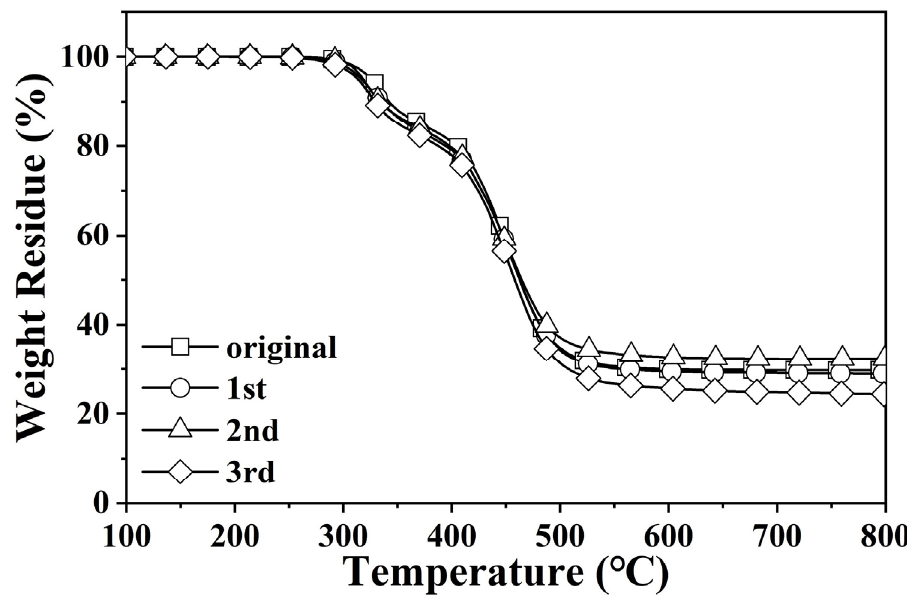
Figure 8. The TGA thermograms of original and reprocessed OBZ-BDB. Table 1. The thermal properties of original and reprocessed OBZ-BDB.